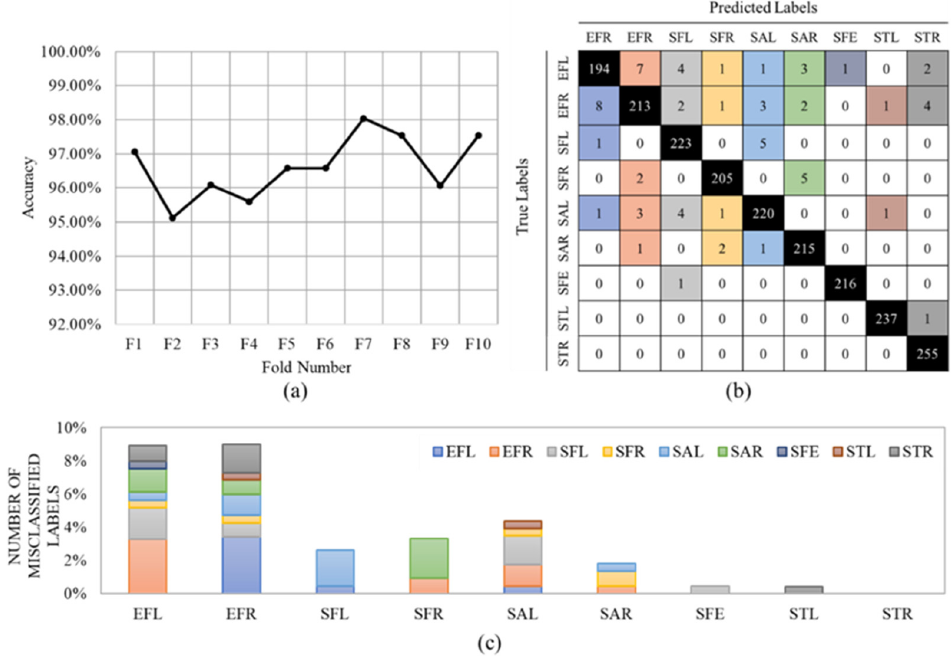
Figure 4. ( a ) The accuracy values per fold in 10-Fold, ( b ) the final confusion matrix, and ( c ) the total number of misclassified labels in 10-Fold. The colors in the confusion matrix ( b ) determine the class of the misclassified label in ( c ).